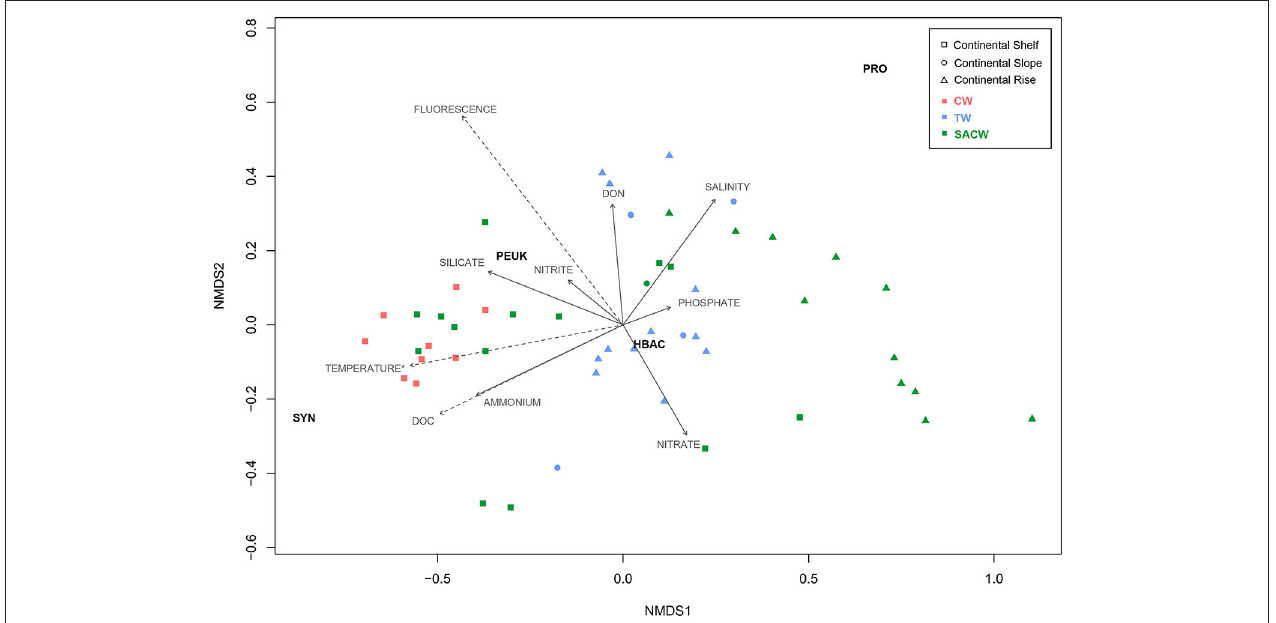
FIGURE 8 | Non-metric multidimensional scaling (nMDS) ordination (stress = 0.059, r 2 = 0.996). Squares represent samples collected on the continental shelf, circles represent samples collected on the continental slope, and triangles represent samples collected on the continental rise. Different colors represent the waters masses: Red is Coastal Water (CW), blue is Tropical Water (TW), and green is South Atlantic Central Water (SACW). Each arrow shows one environmental gradient, and dashed arrows show gradients significantly correlated to the ordination (envfit, p < 0.005). The arrow points to the direction of the most rapid change in the environment (direction of the gradient) and its length is proportional to the correlation between ordination and environmental variable (strength of the